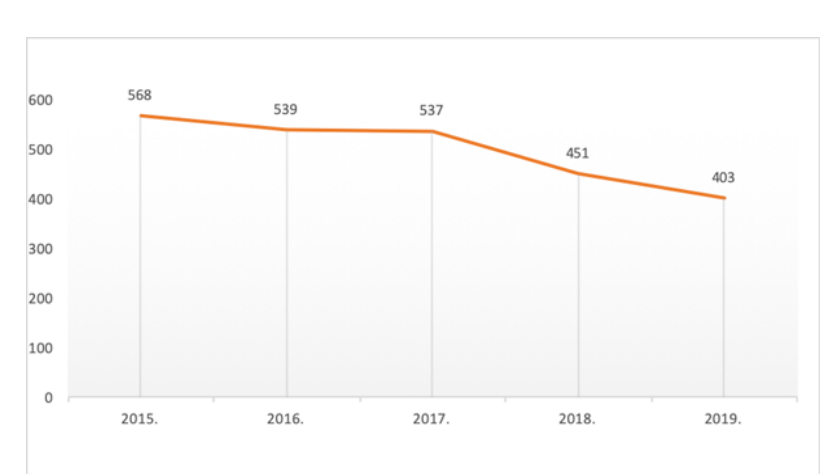
Figure 3: Criminal cases heard by the Supreme Court of the Republic of Lithuania in accordance with Chapter XXXIV of the Code of Criminal Procedure [Designed by the author based on data retrieved from: The Supreme Court of Lithuania, 2020., No. (1.15)5F-2 34 ] A sharp difference can be seen in the volume of cases reviewed when comparing the practice of the Supreme Court of the Republic of Lithuania with the cases of a similar category reviewed by the Supreme Court of the Republic of Latvia. The large number of judgements reviewed clearly indicates possible erroneous final judgements. On the other hand, the extent to which the final decisions in criminal cases have been erroneous can only be inferred from the rulings adopted by the Supreme